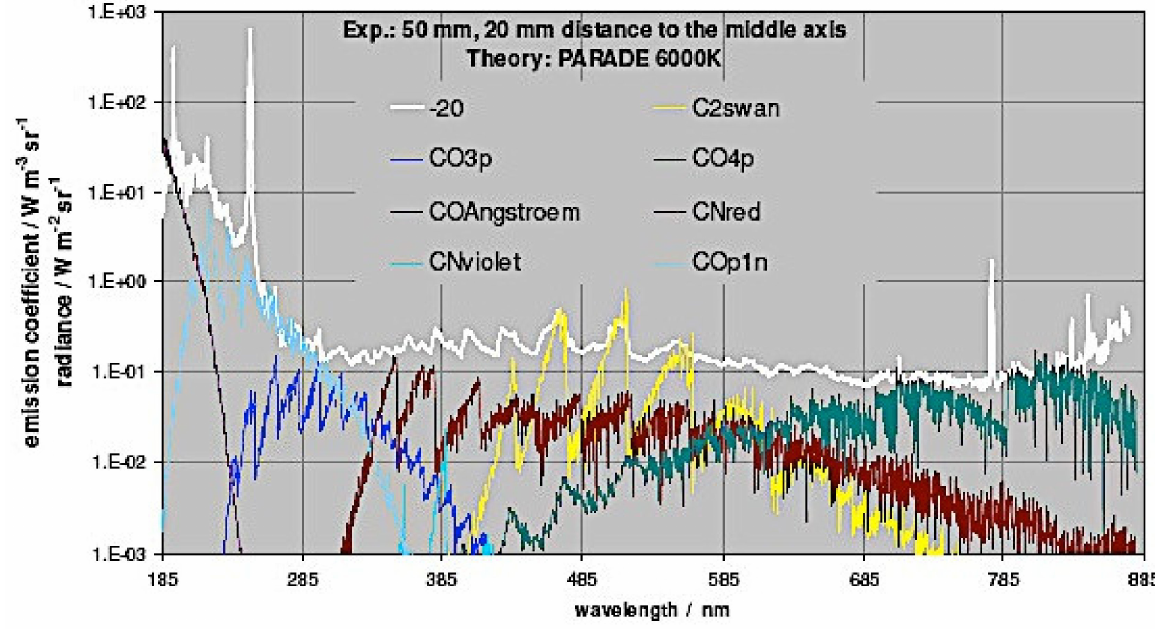
Figure 61. Emission spectra (in white) in PWK-3 at 21 MJ/kg and PARADE calculations with contributions from different systems [6].